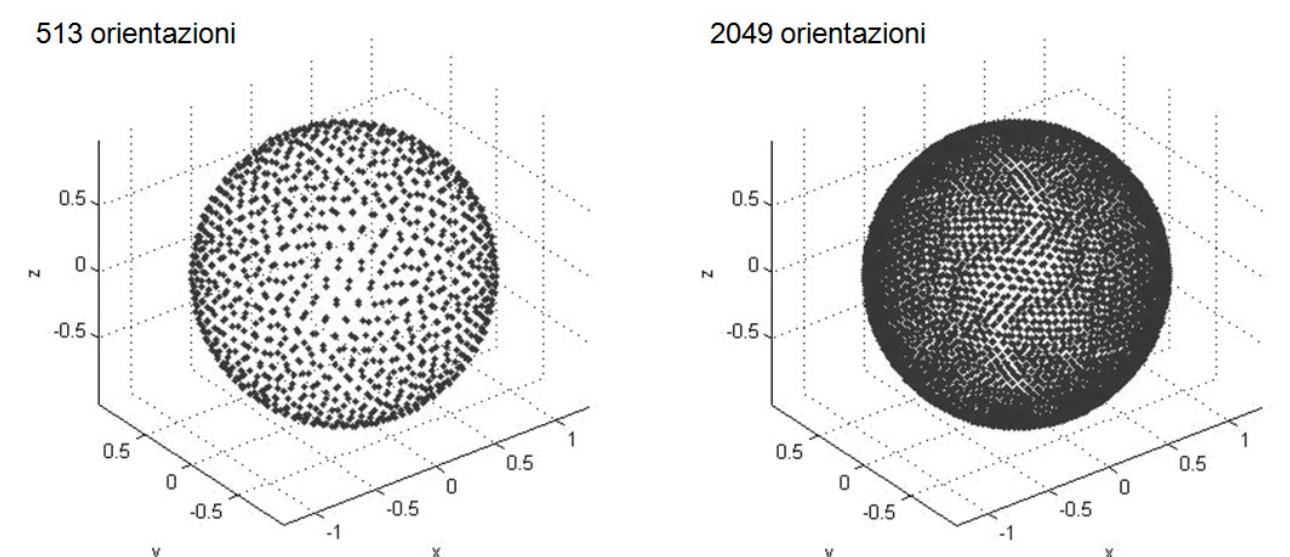
Figura 10: Proiezione delle direzioni di misura sul volume sferico per l’analisi del MIL .